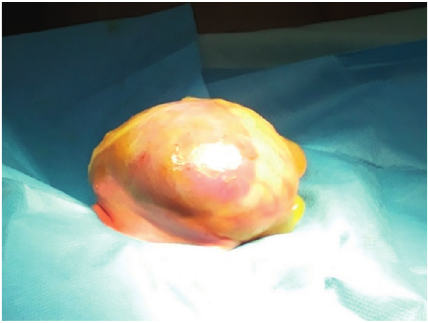
Figure 2: The omphalocele after the first stage of the procedure.